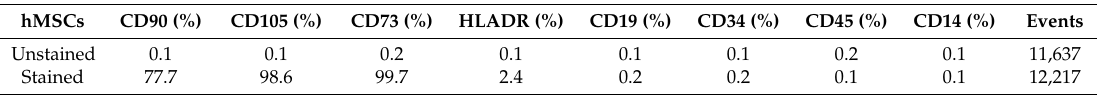
Table 1. Percentage of expression of unstained and stained hMSCs surface proteins and number of events